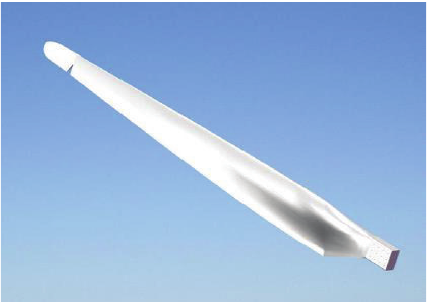
Figure 1: A wind turbine blade made of fibreglass reinforced